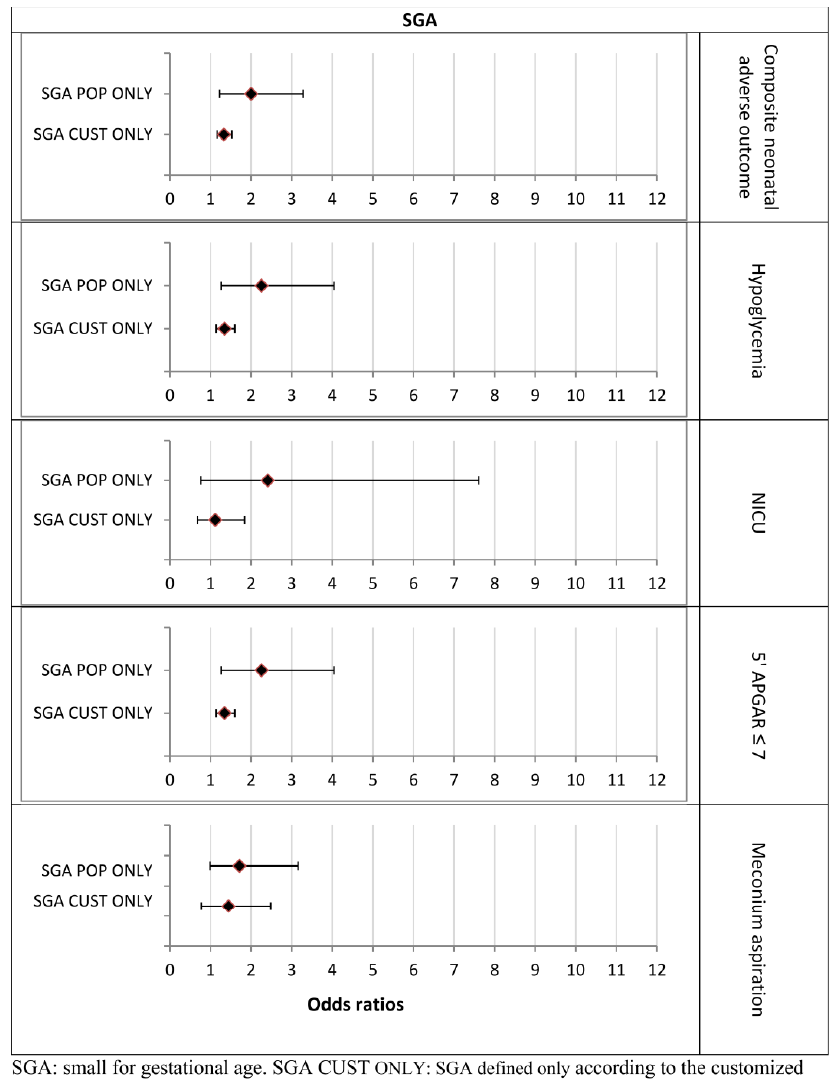
Figure 4. The association between SGA group categorization and adverse neonatal outcomes (Odds ratios, 95% CI). The customized models are adjusted for maternal age. In the LGA population, the risk for any adverse outcome was increased significantly for LGA BOTH and LGA-CUST ONLY (OR = 1.62 95% CI [1.48 – 1.77]; p < 0.0001; and OR = 1.36 95% CI [1.09 – 1.71]; p = 0.007, respectively), compared to the reference population. However, neonates defined as LGA-POP ONLY were not at significantly increased risk for the neonatal composite adverse outcome (OR= 1.19 95% CI [0.97 – 1.45]; p = 0.092) (Table A4). The risks of hypoglycemia and shoulder dystocia were significantly increased for all LGA groups (Figure 5). The risk of shoulder dystocia was highest in the LGA BOTH group (OR = 16.6 95% CI [12.63 – 21.82], p < 0.0001) and was also elevated almost seven-fold in the LGA-CUST ONLY and LGA-POP ONLY groups (Table A5, Figure 5).